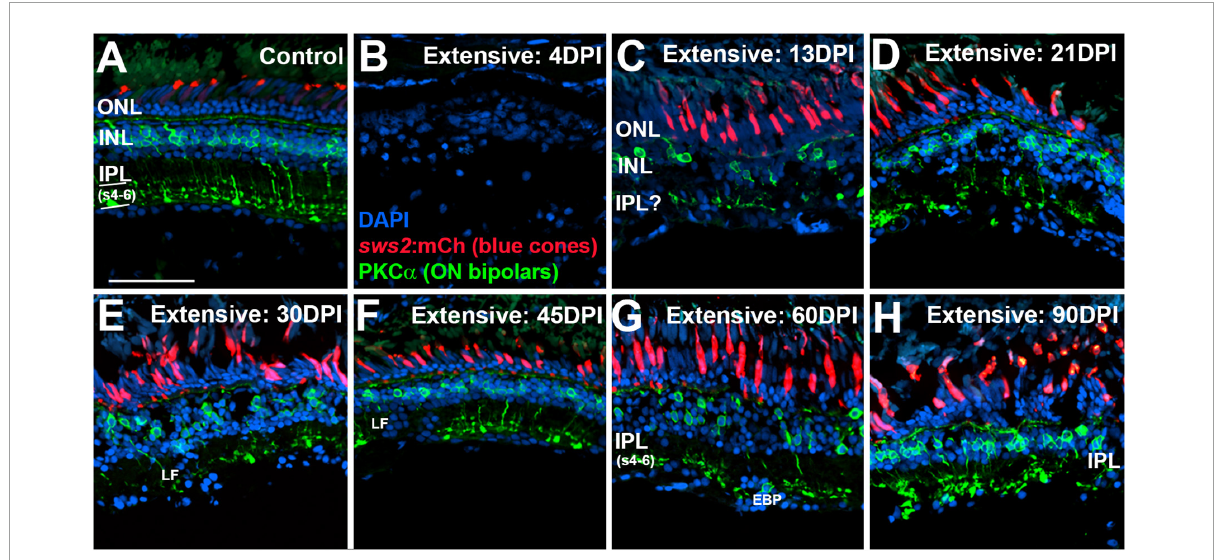
FIGURE6 Time-course of restoration of PKC α + ON bipolar neurons and their synaptic terminals following extensive lesion. Tissues were processed for indirect immunofluorescence and imaging after ERG recordings. (A) Control retina displaying characteristic ON-bipolar synaptic terminals within the deep (s4-6) layers of the inner plexiform layer (IPL). (B) Retinal tissue at 4 days post-injury (DPI), demonstrating loss of retinal structure, and of cell types including sws2 :mCherry + blue cones and PKC α + ON bipolar neurons. (C–H) Regenerating retinas at 13 (C) , 21 (D) , 30 (E) , 45 (F) , 60 (G) , and 90 DPI (H) . Some features of IPL emerge by 13 DPI, but laminar fusions (LF) remain, and PKC α + ON bipolar axon terminals are not entirely localized to IPL sublaminae s4-6. In addition, the occasional ectopic PKC α + nucleus [EBP in panel (G) ] is found in the ganglion cell layer. ONL, outer nuclear layer; INL, inner nuclear layer; scale bar (in A, applies to all) = 50 µ m.